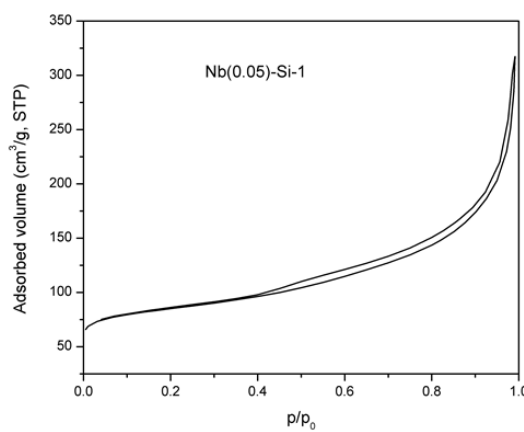
Figure 2. Nitrogen adsorption–desorption isotherms at 77 K for Nb-Si-1.